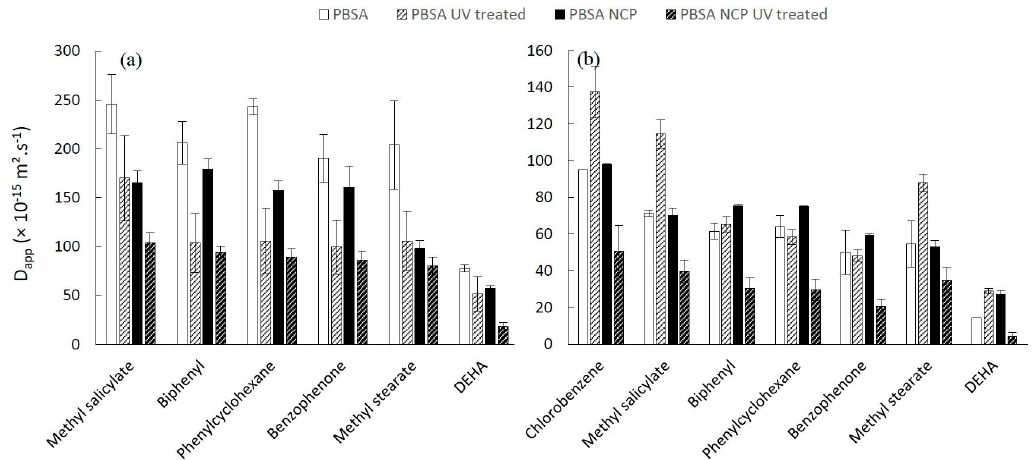
Figure 8. Comparison of D app values of additives in PBSA, PBSA NCP and the corresponding aged materials in contact with 95% ethanol ( a ) and isooctane ( b ).